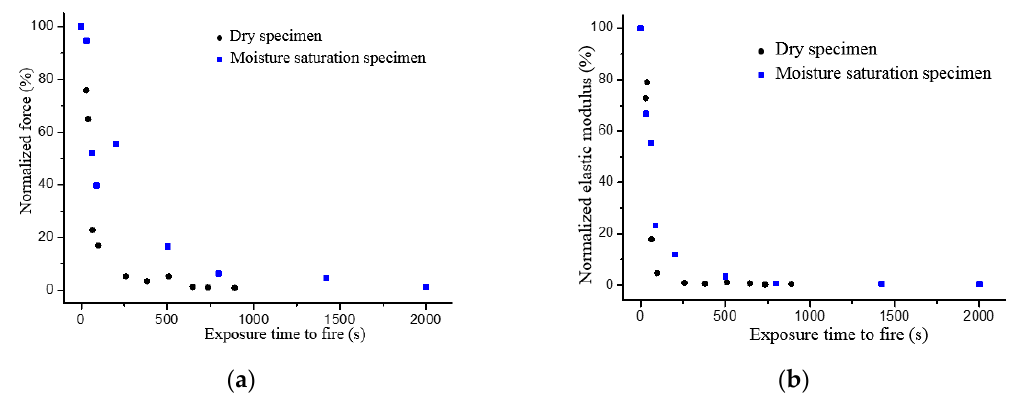
Figure 9. Post-residual flexural mechanical responses as a function of fire exposure time: normalized residual force ( a ) and normalized residual modulus ( b ).